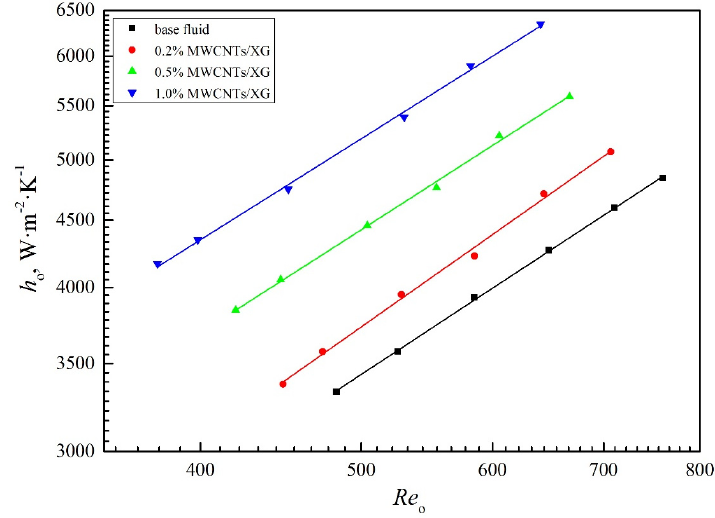
Figure 7. Shell-side heat transfer coefficient versus shell-side Reynolds number.